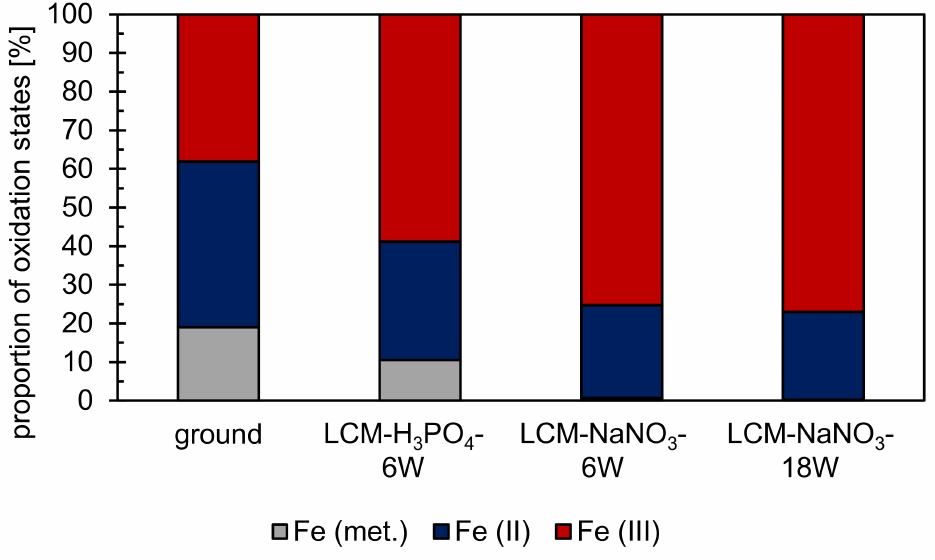
Figure 5. XPS analysis on the proportion of iron oxidation states at the rim zone after surface finishing by LCM and grinding. XPS results of the ground surface were adapted with permission from ref.